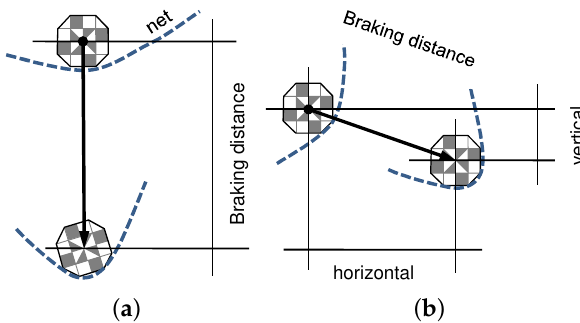
Figure 9. The height difference between the first contact of the block with the system and its lowest position results in potential energy of the block that has to be absorbed by the system: ( a ) for a vertical impact, the full braking distance has to be taken into account, ( b ) for an inclined impact, only the vertical part of the braking distance is relevant.